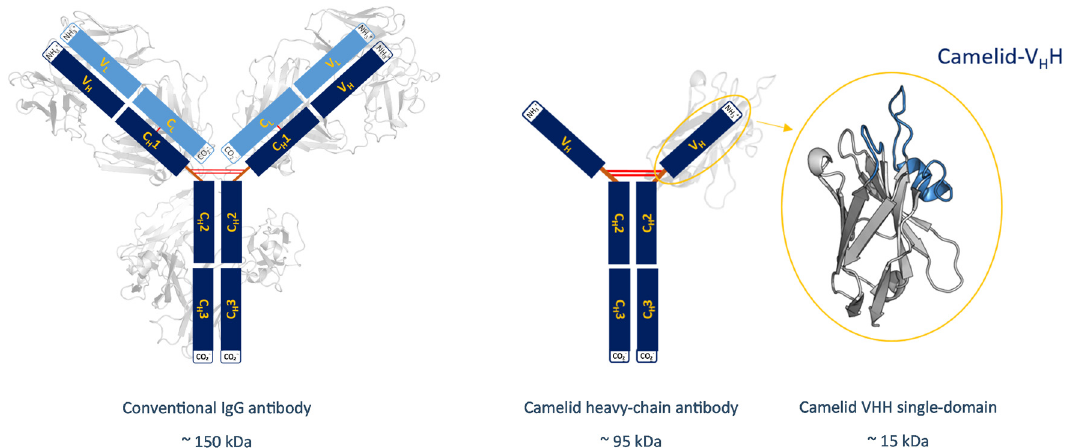
Figure 1. Overview showing the different sizes of antibodies and their derivates. A structural comparison between a conventional IgG-type antibody and a camelid heavy chain antibody with its variable fragment is shown. Next to the schematic representation of the V H H, the structure of the respective single domain is depicted and the CDR 3 and the CDR1 loops highlighted in blue. Additionally, the molecular weights of the structures are shown, which range from 150 kDa for the conventional IgG-type antibody, to only 15 kDa for the V H H single domain.